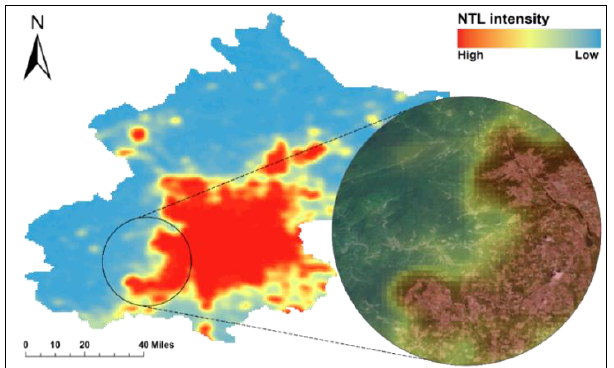
Figure 4. NTL intensity transition of the USR boundary.